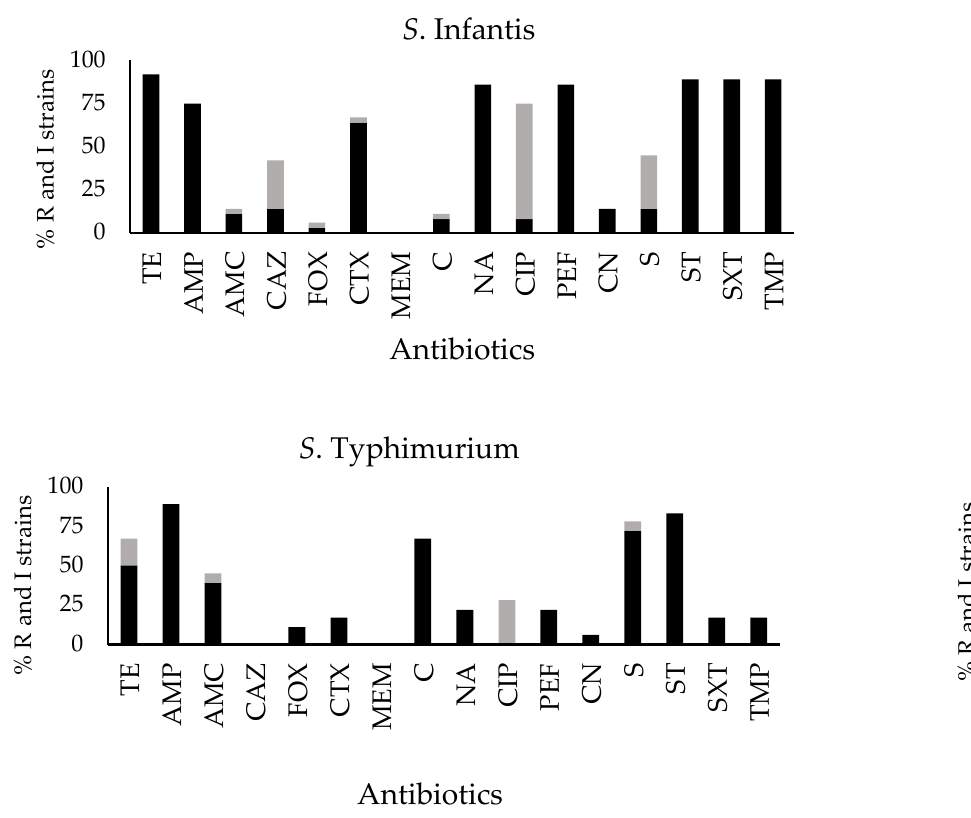
Figure 2. AMR profile of Salmonella strains investigated in this study, according to serovar. R: resistant (black), and I: intermediate (grey) strains. MVST: monophasic variant of S . Typhimurium. AMP, ampicillin; CTX, cefotaxime; CAZ, ceftazidime; AMC, amoxicillin+clavulanic acid; FOX, cefoxitin; MEM, meropenem; TE, tetracycline; C, chloramphenicol; CIP, ciprofloxacin; NA, nalidixic acid; PEF, pefloxacin; CN, gentamicin; S, streptomycin; SXT, trimethoprim-sulfamethoxazole; ST, sulfisoxazole; TMP, trimethoprim.